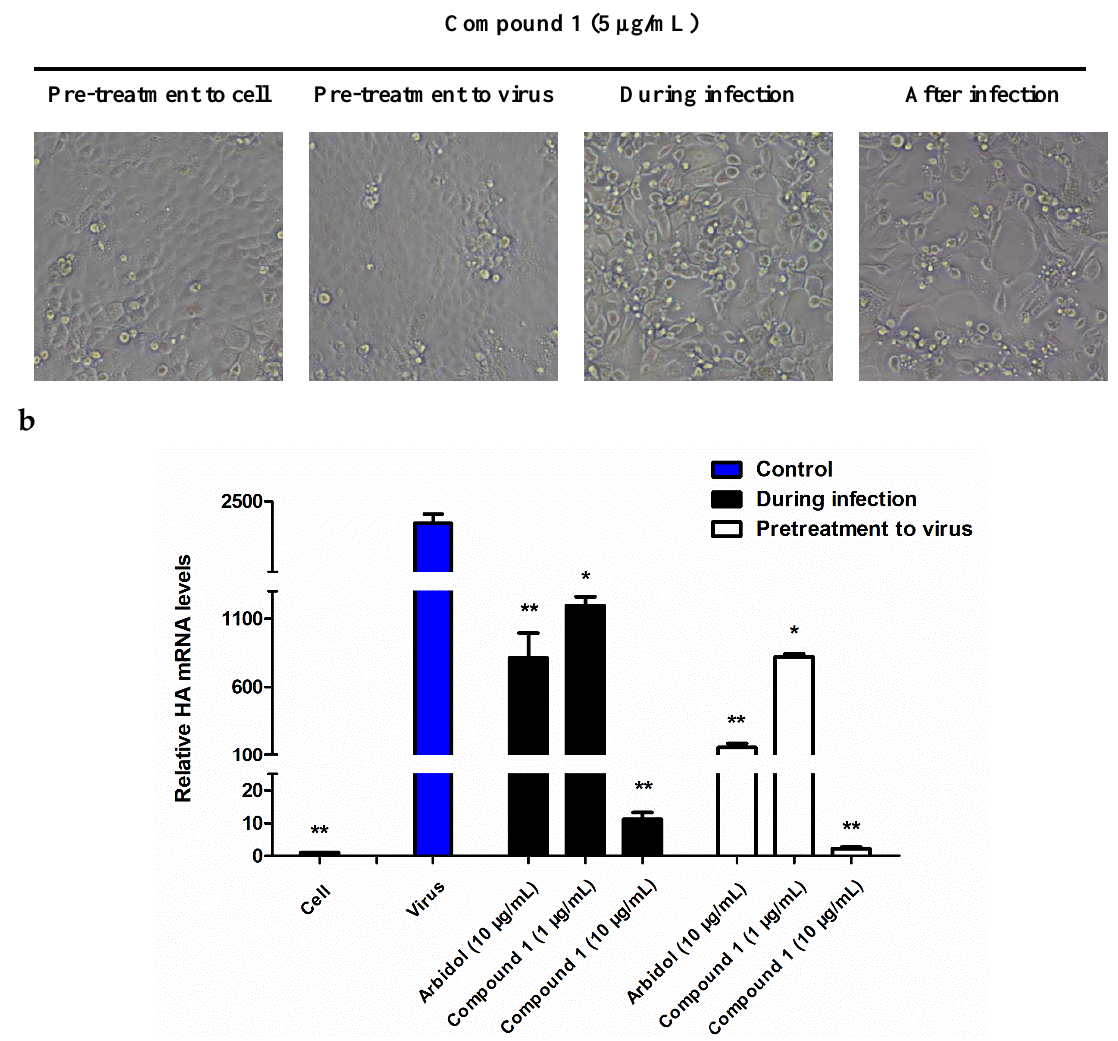
Figure 3. The anti-IAV activity tested with different drug administration approaches. ( a ) Cytopathic effects of H1N1-infected MDCK cells with different drug treatment approaches (100×, the concentration of 1 was 10 µg/mL). ( b ) The antiviral effects of 1 against influenza A/PR/8/34 (H1N1) evaluated by measuring the mRNA level of the HA gene after treatment with 1 with two drug administration approaches, namely, “pretreatment to virus” or “during infection”. Statistical significance of the data in the virus group was defined as * p < 0.05, ** p < 0.01, *** p < 0.001 with the one-way analysis of variance (ANOVA) method.